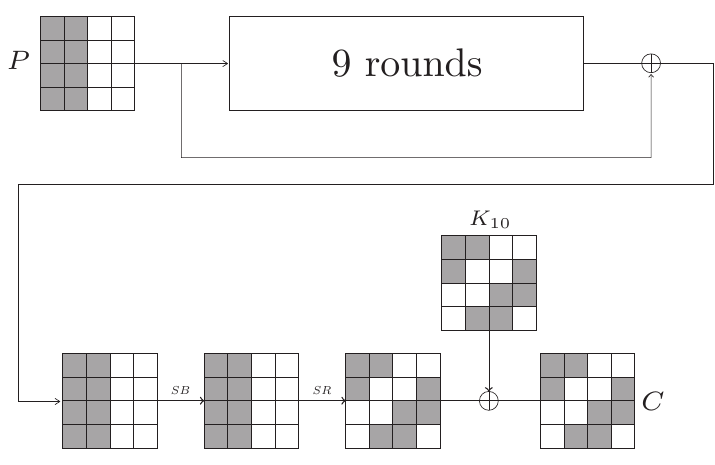
Figure 18: Overview of impossible differential against Dual-AES-PRF 9 , 1